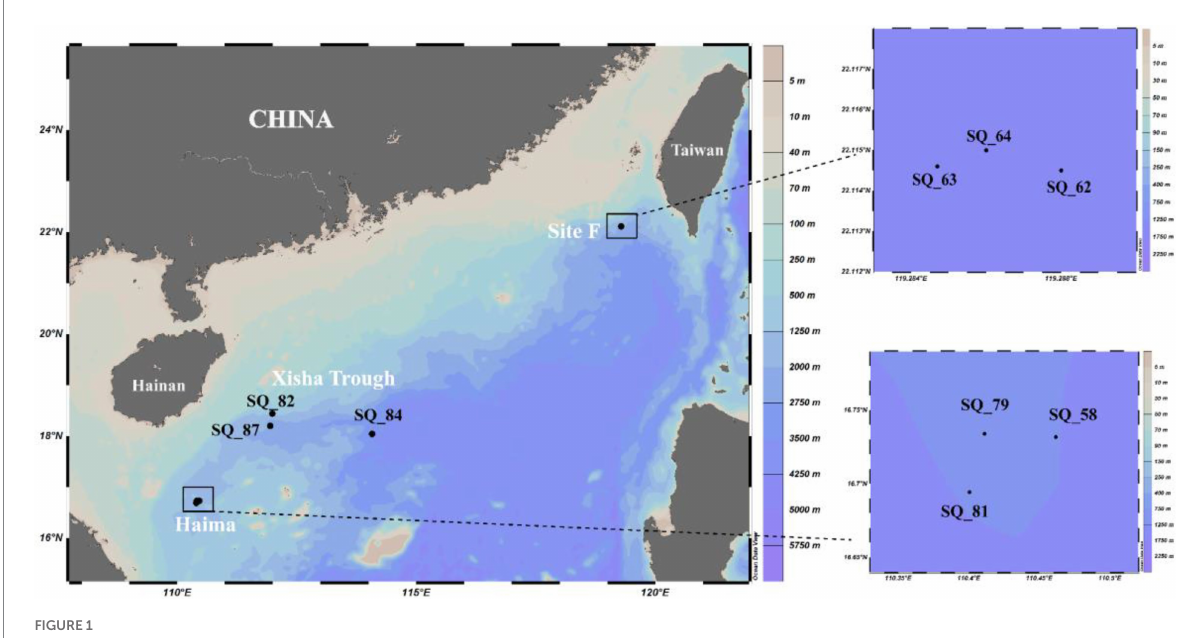
FIGURE 1 Location of the sampling stations in the South China